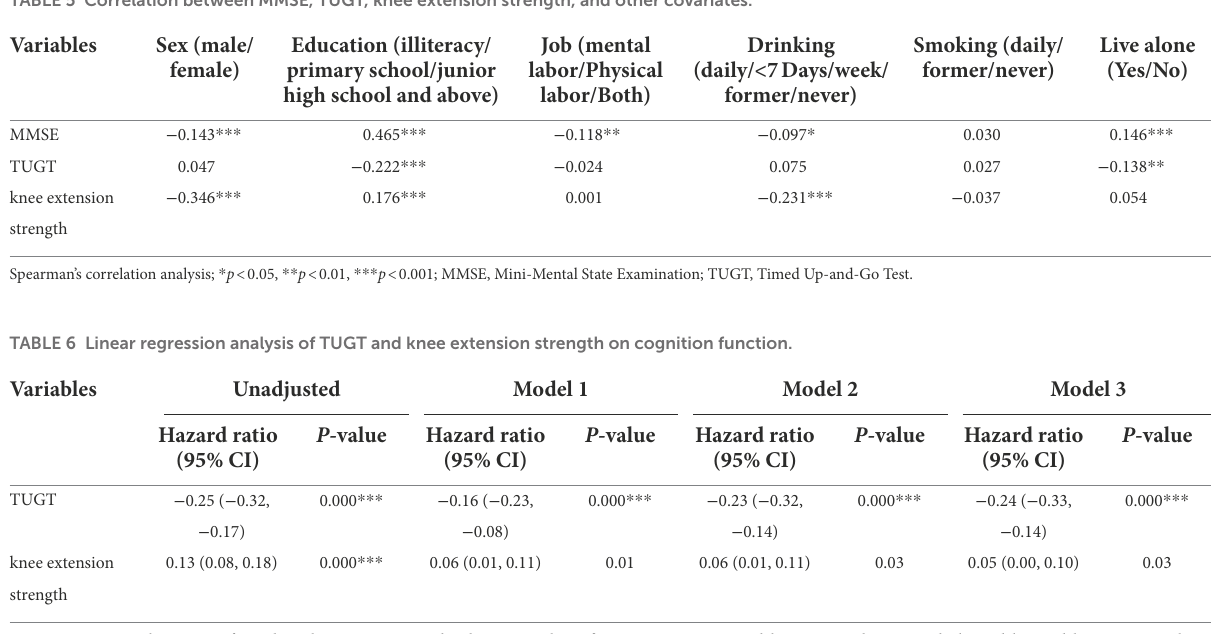
TABLE 5 Correlation between MMSE, TUGT, knee extension strength, and other covariates.